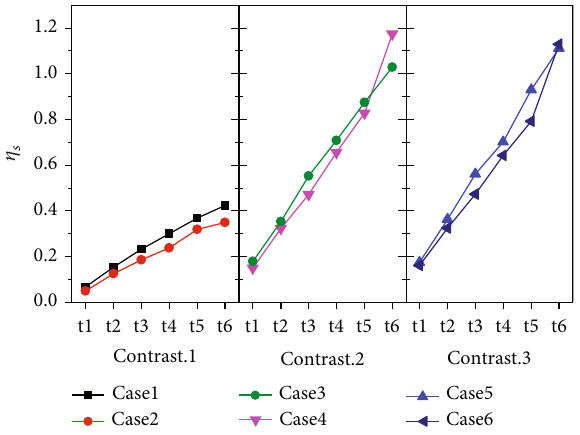
Figure 11: Comparative results of dimensionless icing areas. Figure 12: Comparative results of the dimensionless thickness of the icing stagnation